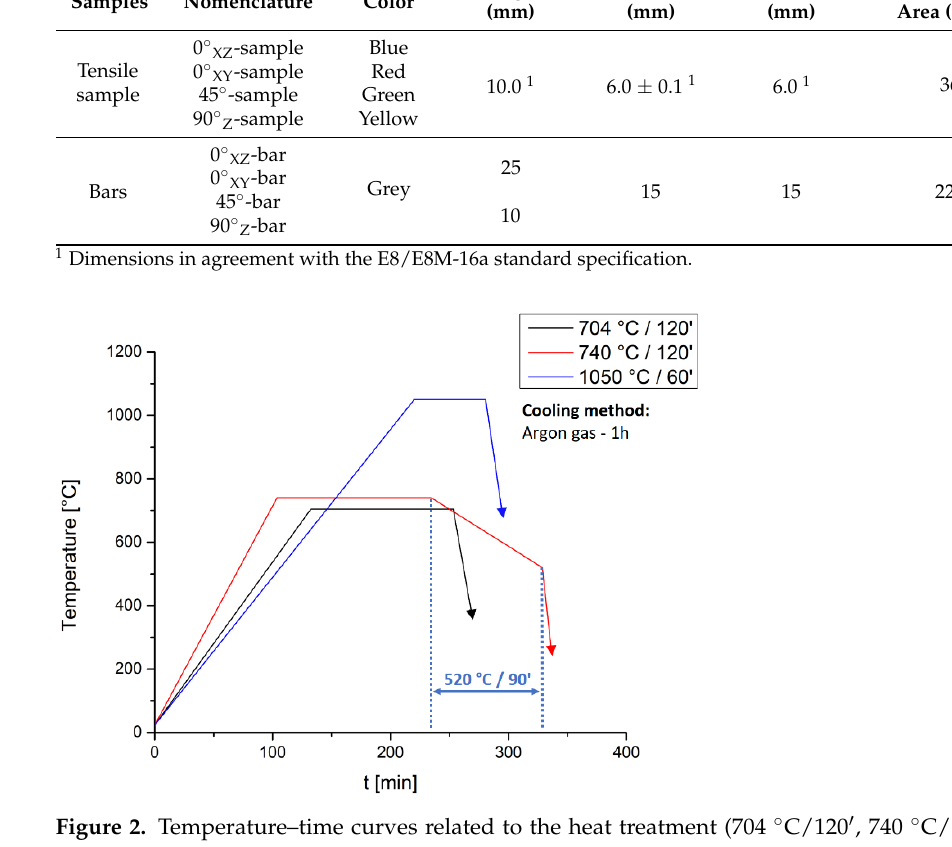
Figure 1. ( a ) Solidworks (Dassault Systèmes, Waltham, Québec, Canada) drawing of tensile samples manufactured along the 0° XZ (blue), 0° XY (red), 45° (green) and 90° Z (yellow) directions and of bars grown along the same directions; ( b ) skin-core scan strategy where θ is 56.5° and the orange and red arrows indicate the laser scans directions. Table 2. Nomenclature used in the present paper for all tensile samples and bars and their dimensions. Samples